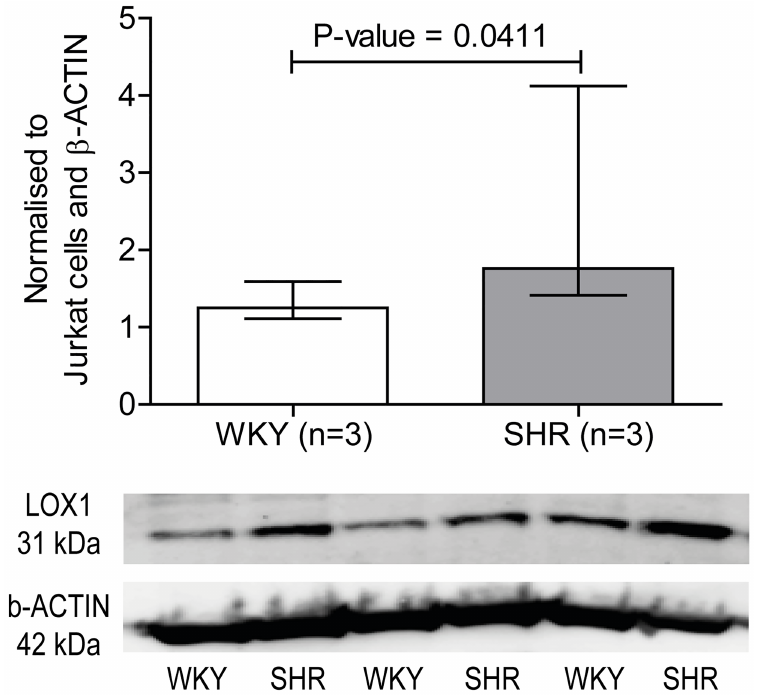
Fig 4. LOX1 protein level. LOX1 (also known as OLR1) expressionin the cerebralarteries from SHRs comparedto WKY rats and representative blot of LOX1 and β -ACTIN. Data is normalized to Jurkat cells and β -ACTIN. Data is expressedas median ± interquartile range, and n represents the numberof rats. P-value < 0.05 is considered statistical significant.